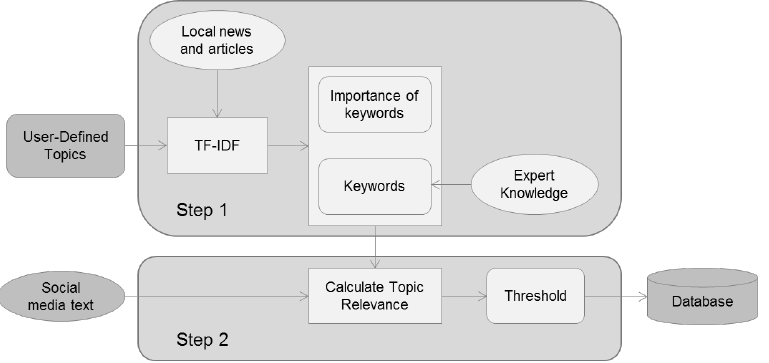
Figure 2. A two-step procedure to automatically identify relevant social media